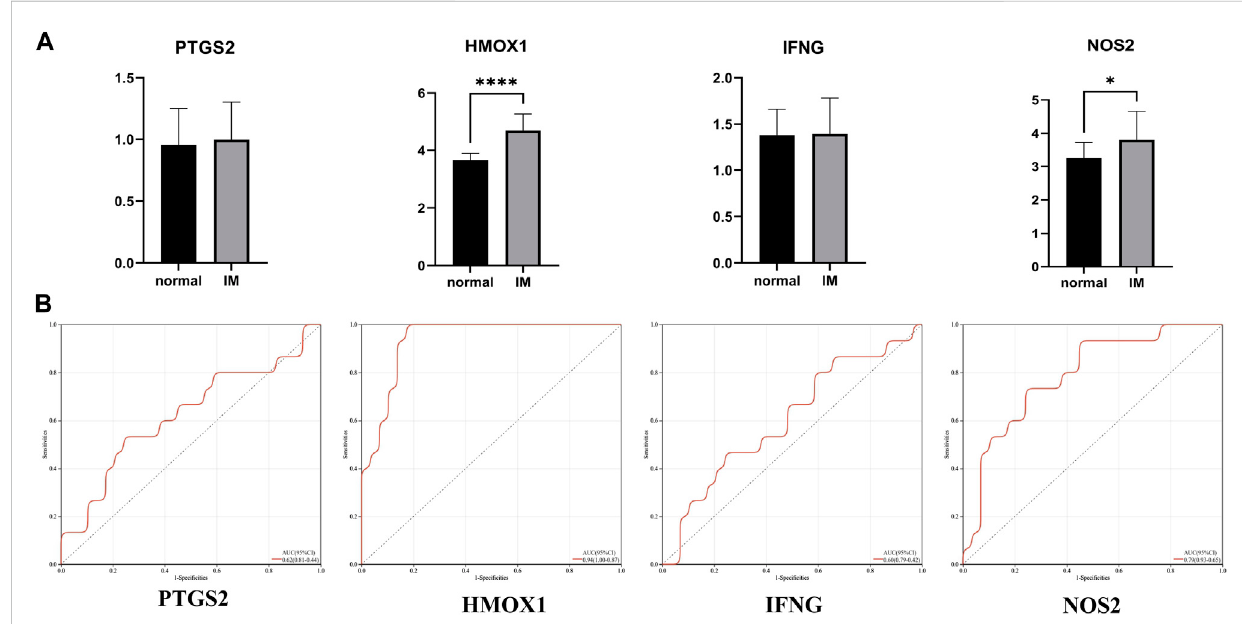
FIGURE 6 (A) Relative expression of PTGS2, HMOX1, IFNG, and NOS2 in GSE78523 dataset. (B) The receiver operating characteristic (ROC) curve of PTGS2, HMOX1, IFNG, and NOS2 in GSE78523 dataset. * p < 0.05; **** p <